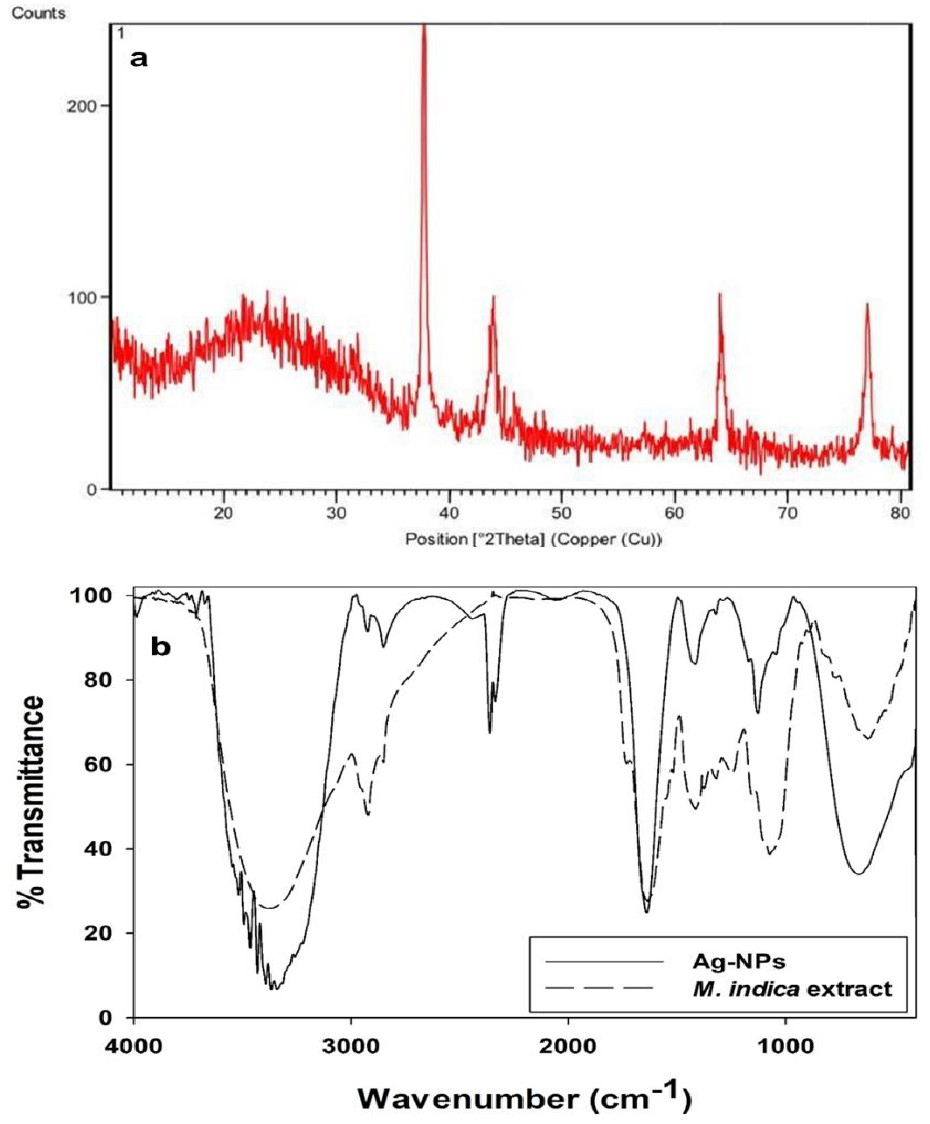
Figure 2. ( a ) X-ray diffraction pattern of MK-AgNPs. ( b ) FTIR Analysis of synthesized MK-AgNPs. X- ray diffraction pattern displayed diffraction peaks at 2θ of 37.7°, 44.0°, 64.0°,